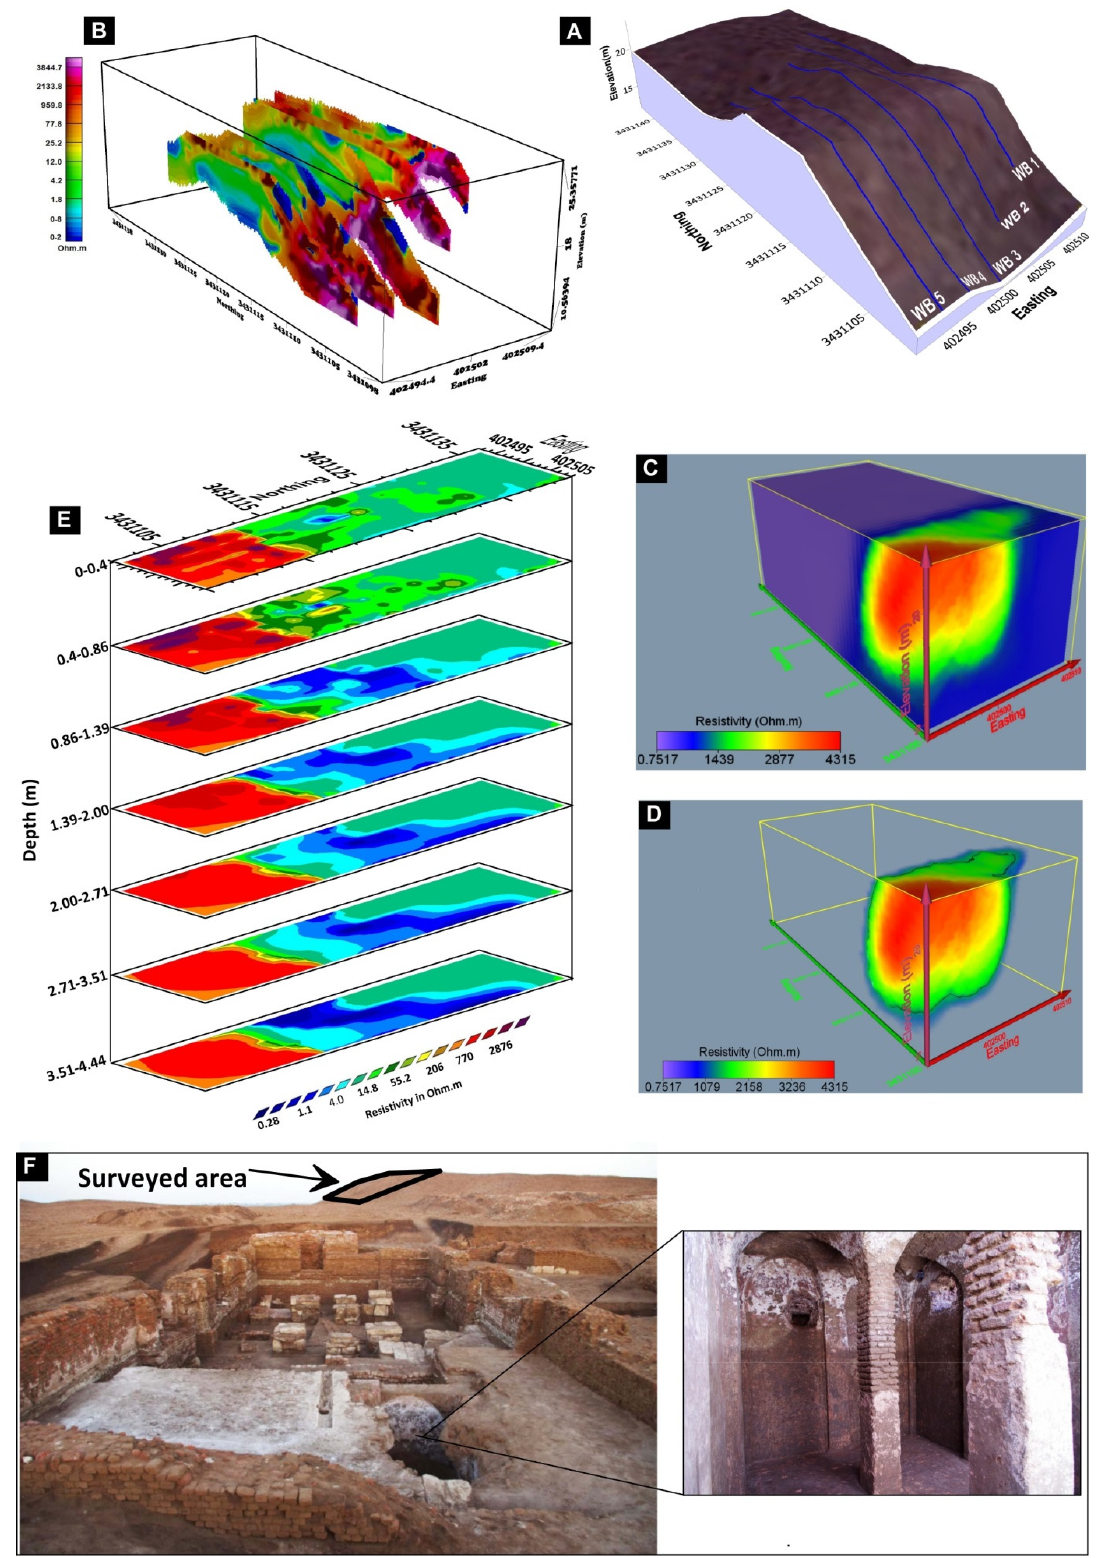
Figure 12. Results of 3D-quasi-ERT at the area around Spot C: ( A ) 3D geometry of the actual location of the five measured parallel profiles; ( B ) pseudo-3D inverted models along five parallel profiles; ( C ) working resistivity cube of the 3D inversion results; ( D ) 3D visualization of iso-resistivity surfaces; ( E ) horizontal resistivity-depth slices from 0 to 4.4 m; and ( F ) general view of the church unearthed in the heart of the medieval city of Dibgou by the MATD campaign in September